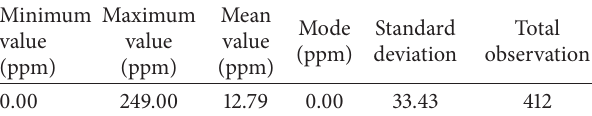
Table 7: Mean yearly carbon monoxide concentration ( 𝑌 ), newly